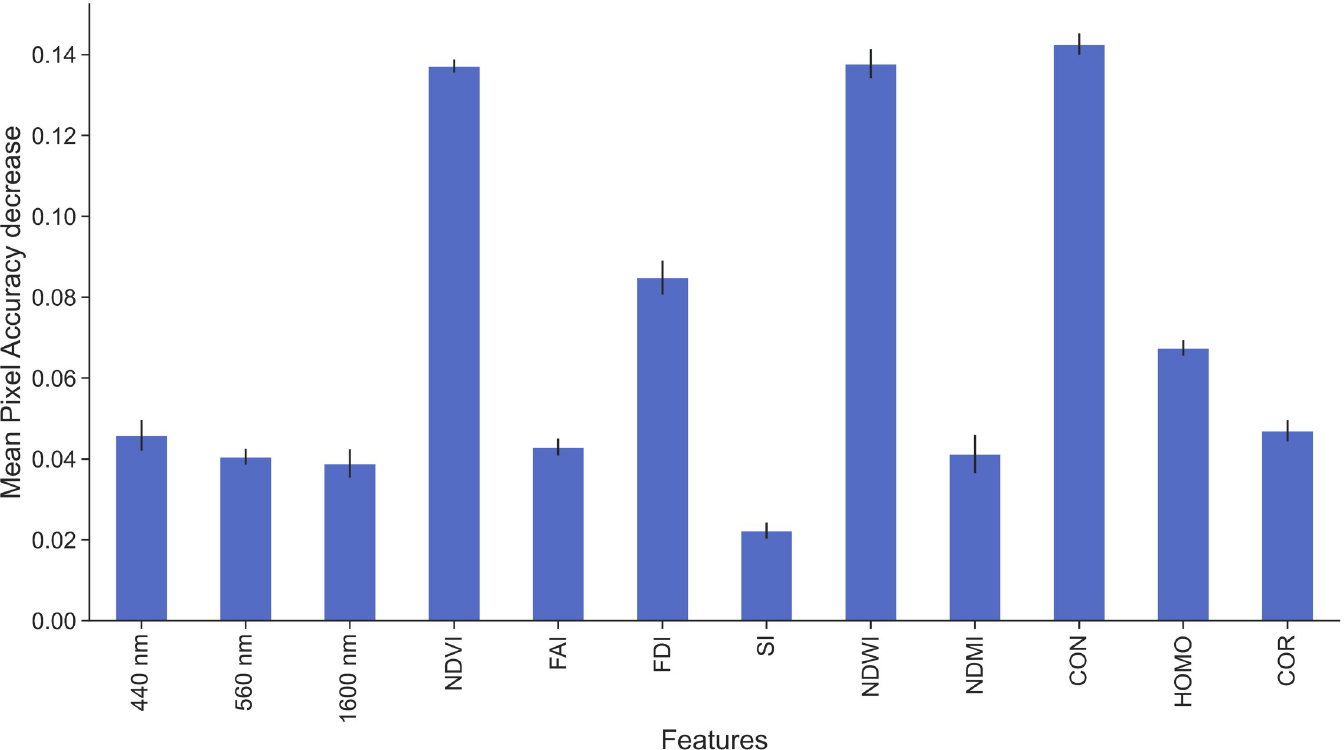
Fig 6. Features importance using permutation on RF SS+SI+GLCM model. Each feature represents a different highly correlated group. The largest mean pixel accuracy decrease occurs by permuting CON, NDWI, NDVI and FDI.